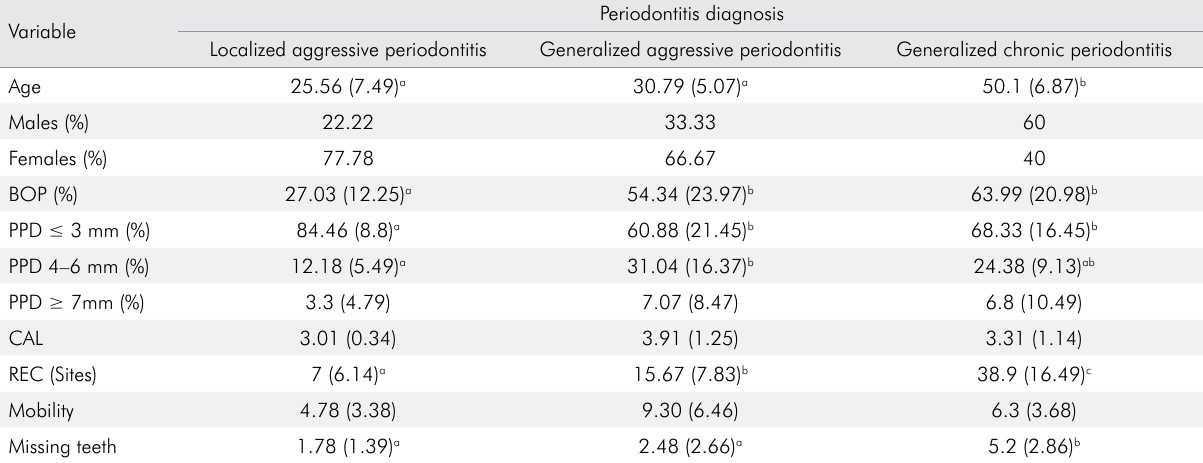
Table 1. The chi-square test was used to analyze the significance of the gender distribution differences between the groups (p = 0.19; no significant difference between